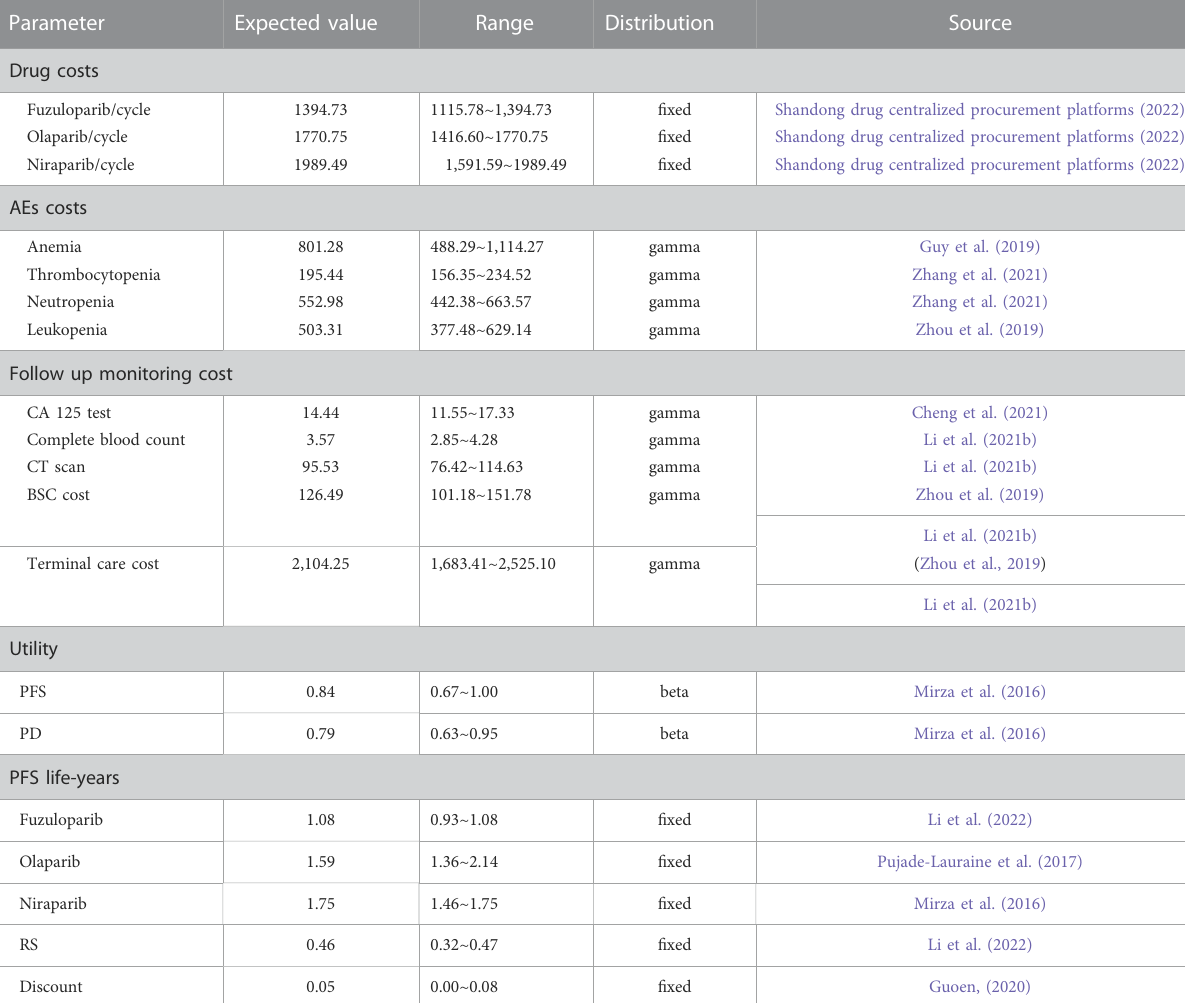
TABLE 1 Model parameters: baseline values, ranges, and distributions for sensitivity